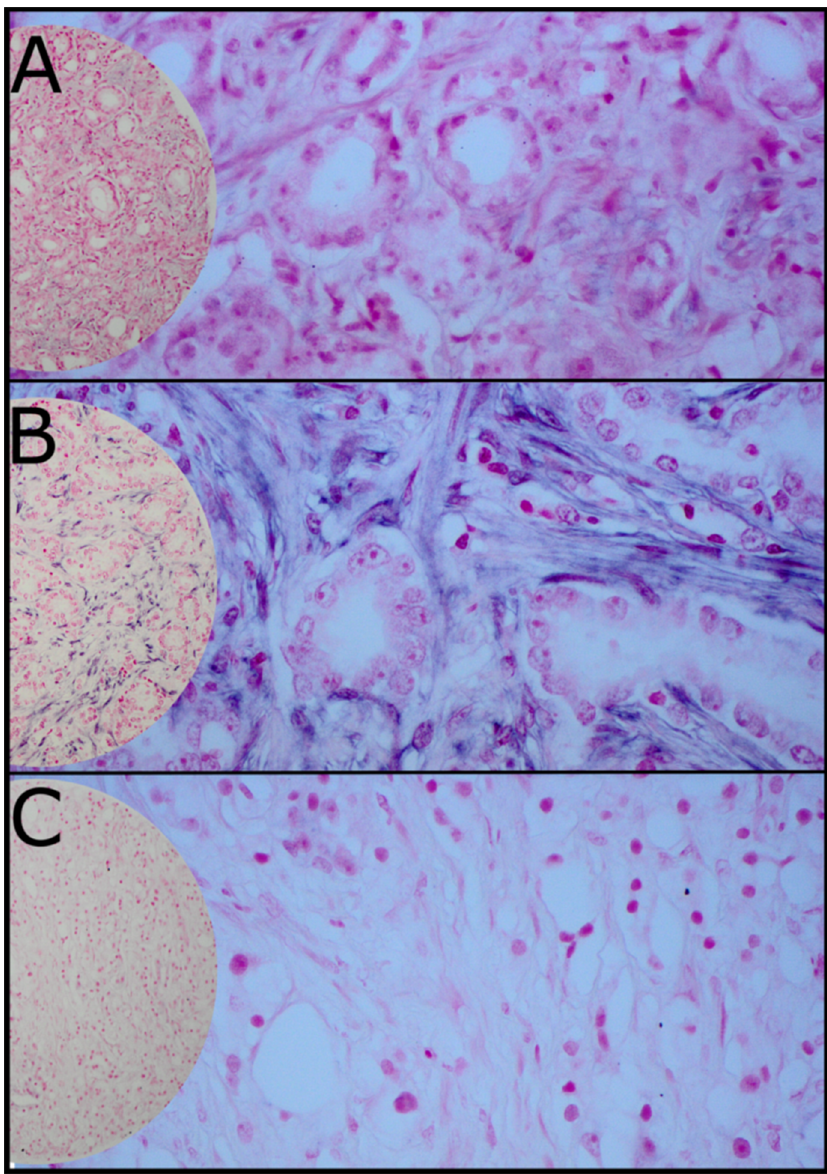
Figure 2. In situ hybridization (ISH) analysis of prostate cancer representing Gleason Grade (GS) , 7 (A), GS 7 (B) and GS , 7 (C), (200x and 400x magnification).